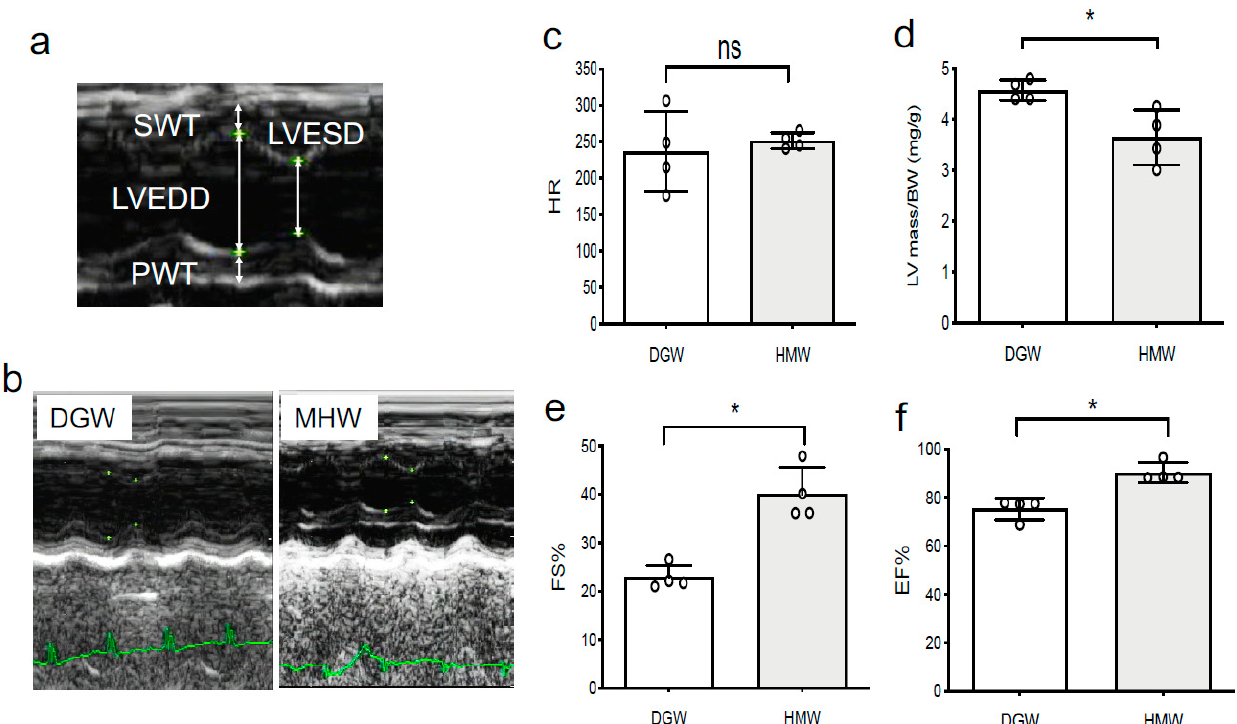
Figure 6. The physiological cardiac function in DIO mice treated with DGW or MHW for 14 days. ( a ) Parameters (LVEDD, LVESD, LV SWT, and LV PWT) to evaluate cardiac function in the M-mode view of mouse echocardiography. ( b ) Cardiac electrocardiography M-mode views of DIO mice in the DGW and MHW groups. ( c ) Heart rate. ( d ) LV mass/BW (mg/g) calculated using the formula LV mass (mg/g) = [(LVEDD + SWT + PWT) 3 − LVEDD 3 ] × 1.055/BW. ( e ) % fractional shortening (FS%) = [(LVEDD − LVESD)/LVEDD] × 100%. ( f ) %ejection fraction (EF%) = [(LVEDD − LVESD) 3 ]/LVEDD 3 ] × 100%; ns, not significant; * p < 0.05.